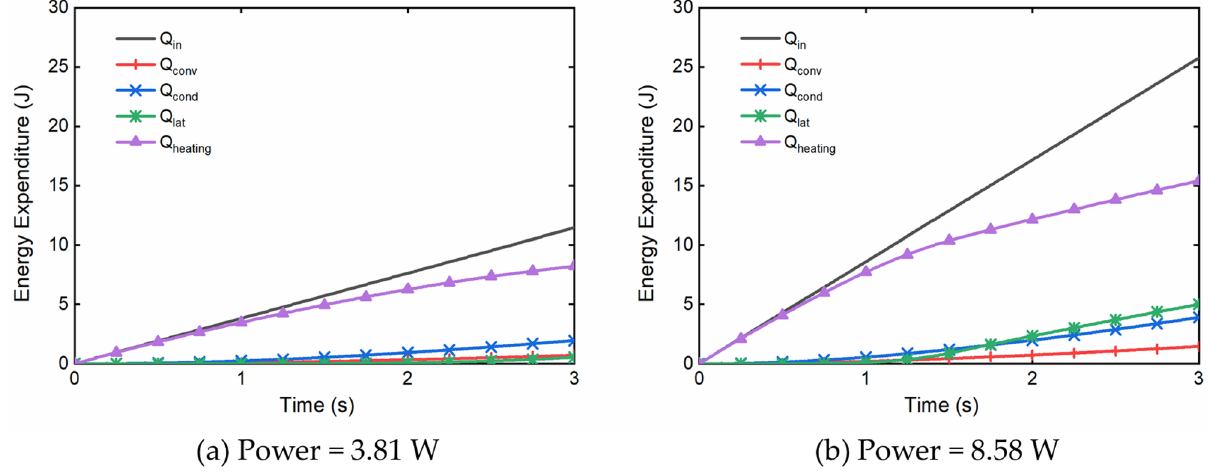
Figure 5. Predicted energy expenditure for a 50/50 (vol%/vol%) PG/VG liquid at two power levels: ( a ) 3.81 W and ( b ) 8.58 W, with 0.44 wick porosity, 3 s puff duration, 30 s puff interval and 55 mL puff volume. Q in is